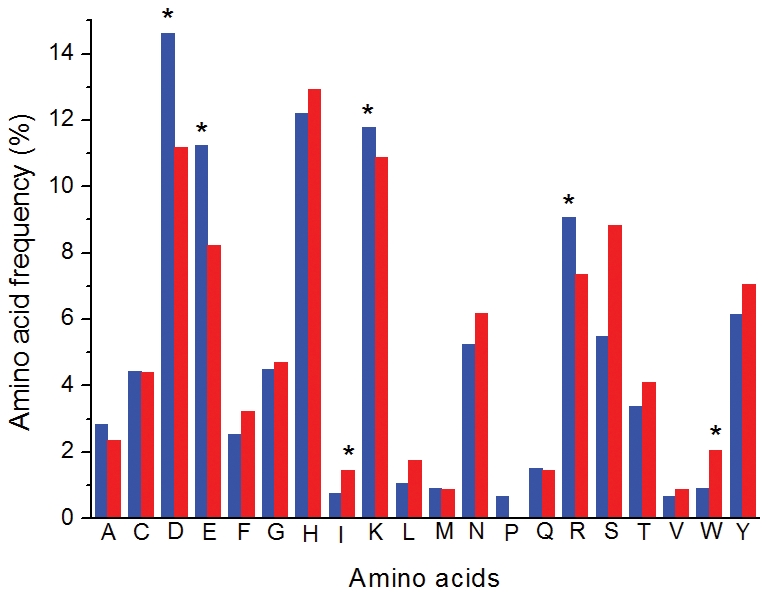
Amino acid compositions of catalytic sites in anaerobic (in blue) and aerobic (in red) enzymes.It can be seen that anaerobic enzymes use polar amino acid residues (e.g., Asp, Glu, Lys and Arg) in catalytic sites more frequently (P<0.05), while aerobic enzymes use non-polar residues (e.g., Trp and Ile) more often (P<0.05).